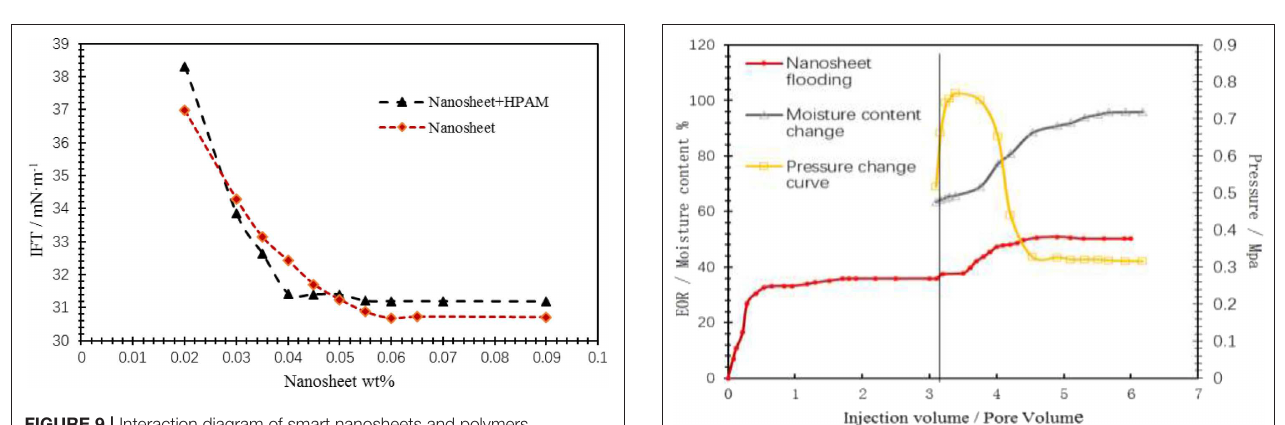
FIGURE 9 | Interaction diagram of smart nanosheets and polymers. TABLE 6 | Displacement of nanosheets.